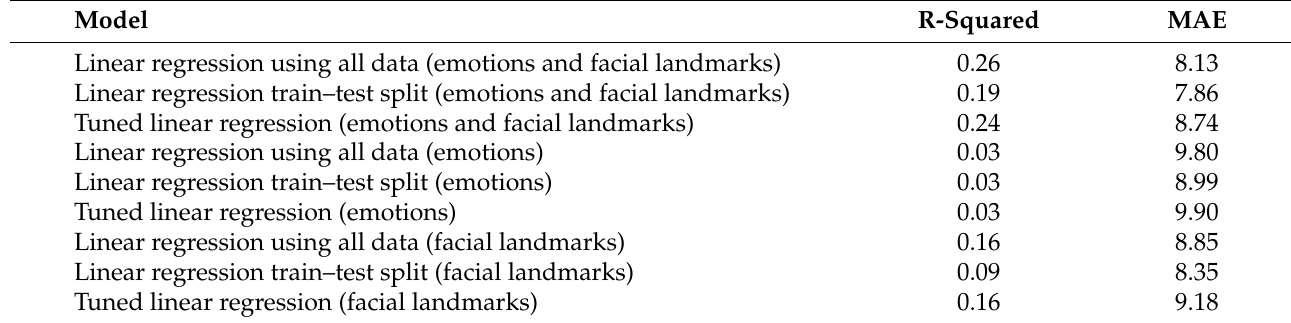
Table 3. Performance of the predictive